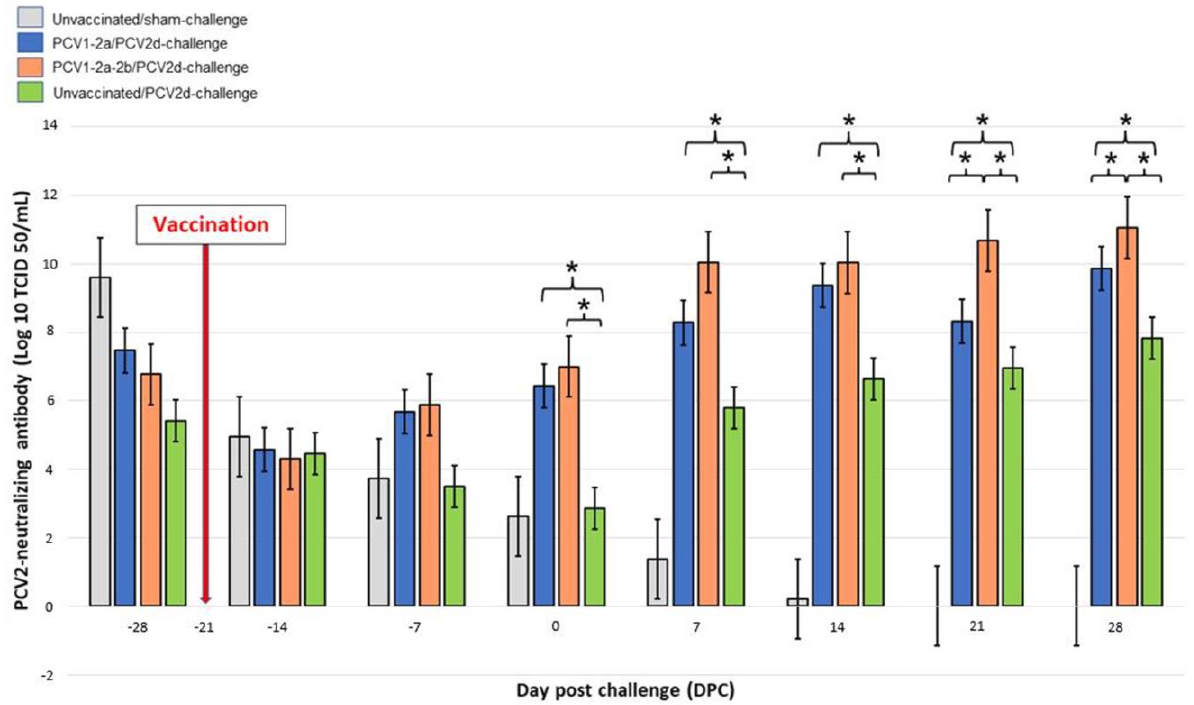
Figure 3. PCV2d-neutralizing antibody levels determined by immunoperoxidase monolayer assay (IPMA). Three weeks after vaccinations, neutralizing antibody levels of the vaccinated pigs increased and were found to be significantly different when compared with those of pigs of the unvaccinated/PCV2d-challenge group. Significant increases were observed in the PCV2-specific neu- tralizing antibodies of the PCV1-2a/PCV2d-challenge or the PCV1-2a-2b/PCV2d-challenge groups throughout the course of this study when compared with the unvaccinated/PCV2d-challenge group. Data are presented as mean ± standard error. Asterisks indicate statistically significant differences (* p < 0.05).